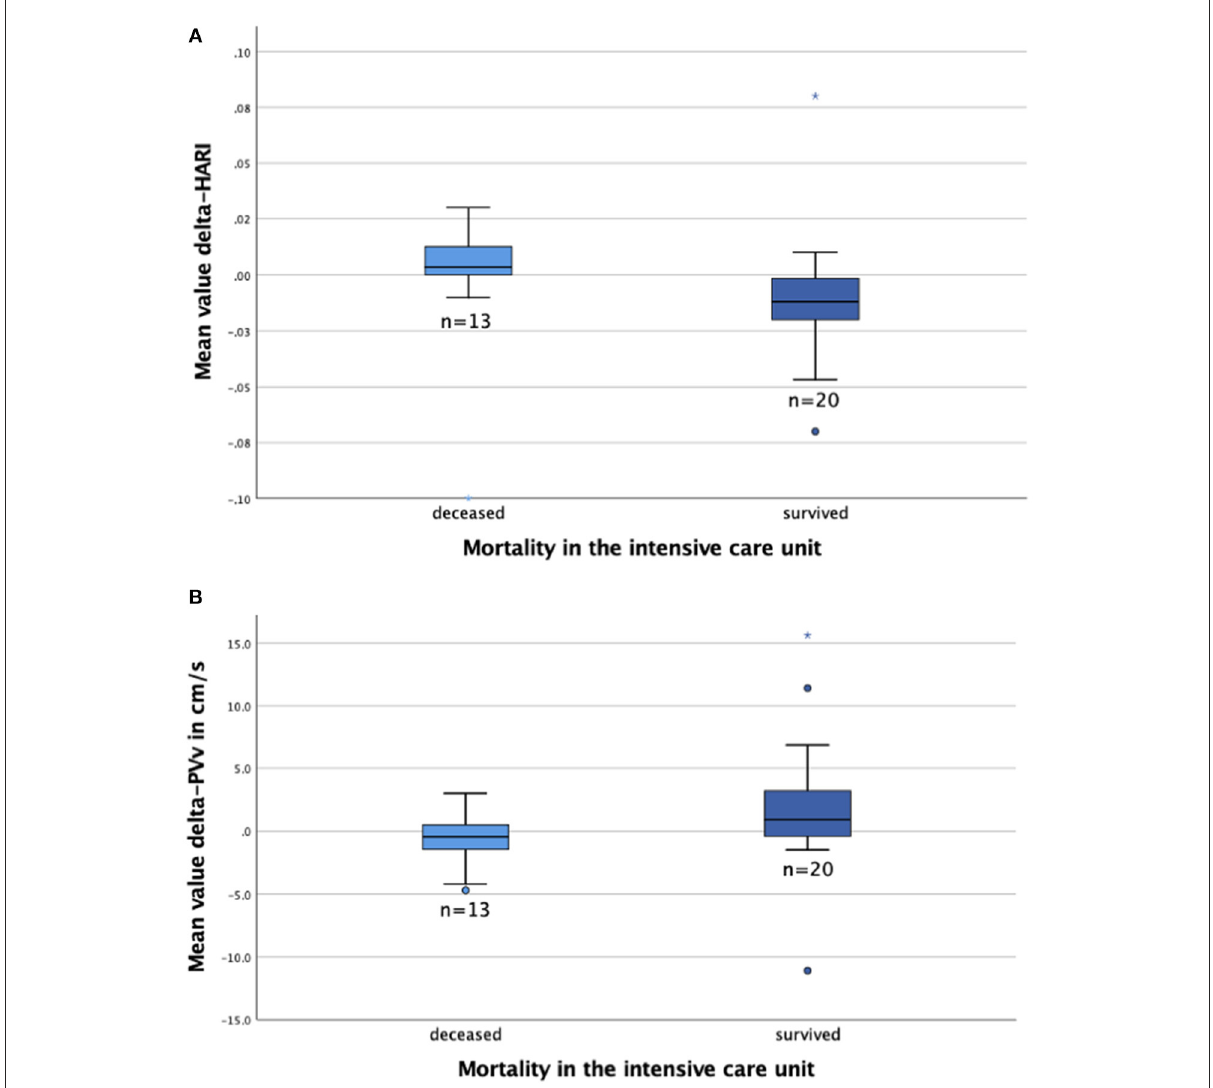
FIGURE4 Boxplots to compare the MELD score and perfusion parameters for deceased ( n = 13) and survived ( n = 20) patients. The figures show the median (line in the middle of the box), 1 st /3 rd quartile (lower/upper edge of the box), minimum (lower whisker), maximum (upper whisker) and outliers* ◦ . (A) Delta-HARI is higher in deceased patients than in survived patients; (B) Delta-PVv is lower in deceased patients than survived patients. HARI, hepatic artery resistance index; PVv, portal vein